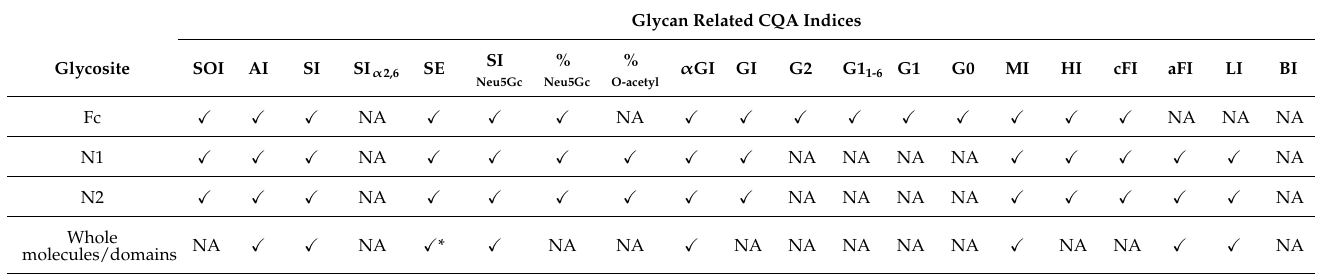
Table 3. An example matrix of the N-glycan-related indices, relevant at site-specific and whole molecule level, for an antibody Fc fusion protein, expressed in CHO cells, as exemplified in Figure 2. Glycan Related CQA